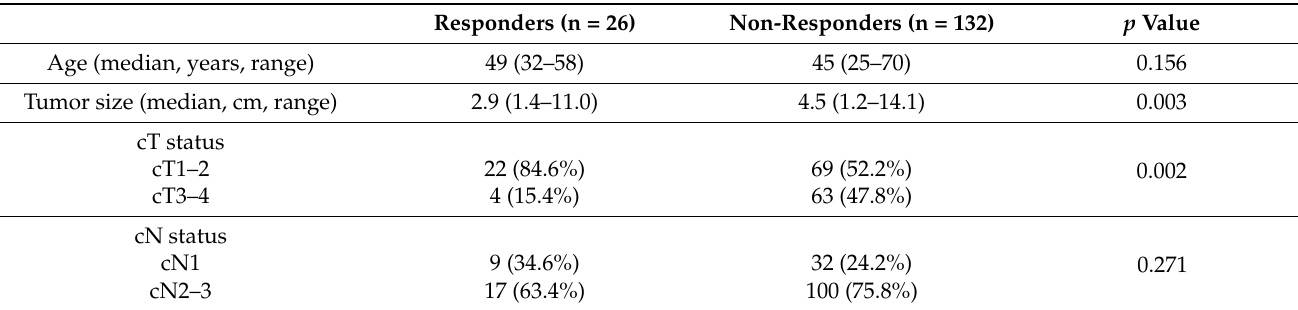
Table 3. Characteristics of responders and